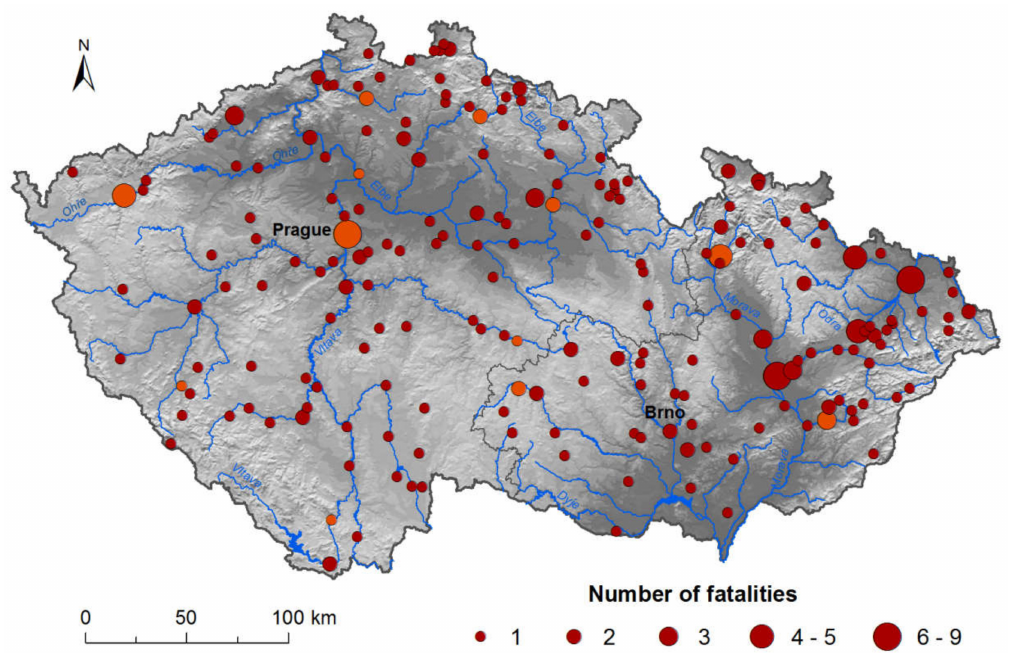
Figure 7. Spatial distribution of settlements with some fatalities during HMEs over the territory of the Czech Republic in the 1981–2018 period (settlements that served as centres of report for a whole district appear in light